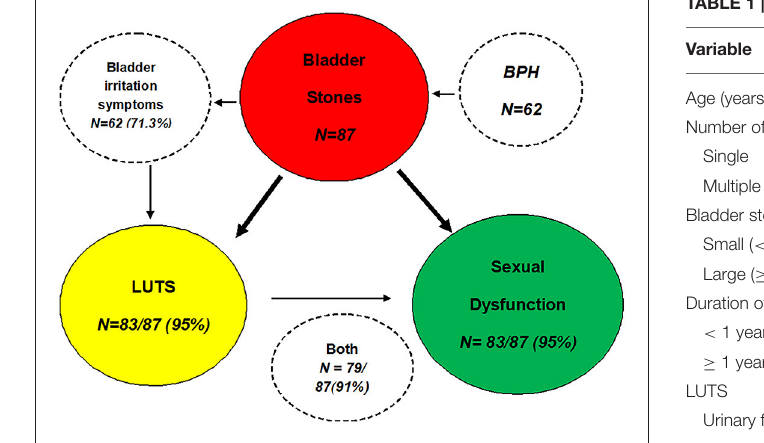
included in the study. The average age of the 87 patients was 54.7